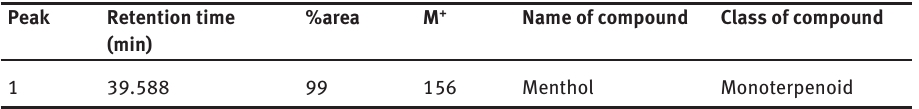
(Figure 5): 1 H-NMR (CDCl